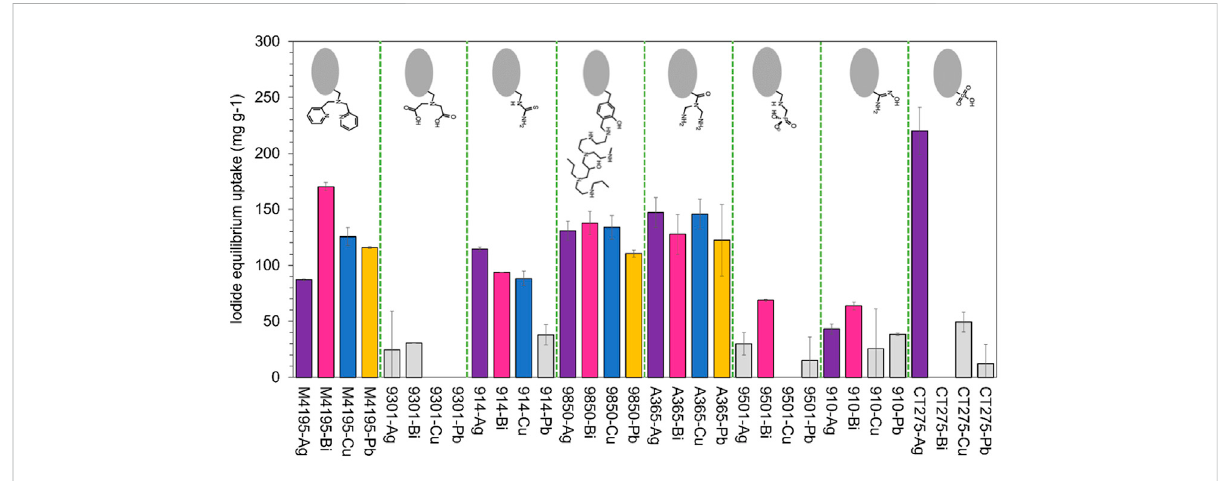
FIGURE 3 Uptake of iodide from NaI solutions by the 32 different metallated adsorbents. Iodide concentration = 1.00 g L − 1 . Solution volume = 25 ml. Adsorbent hydrated mass ≈ 0.1 g. Contact time = 48 h. T = 20 ° C. Materials not progressed to second round are shown in